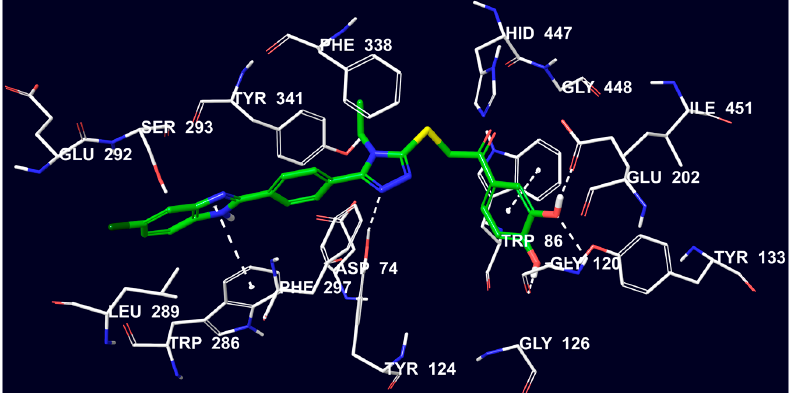
Figure 7. The interacting mode of compound 3h in the active region of AChE. The inhibitor, colored with green, and the important residues, colored with white, in the active site of the enzyme are presented by tube model.